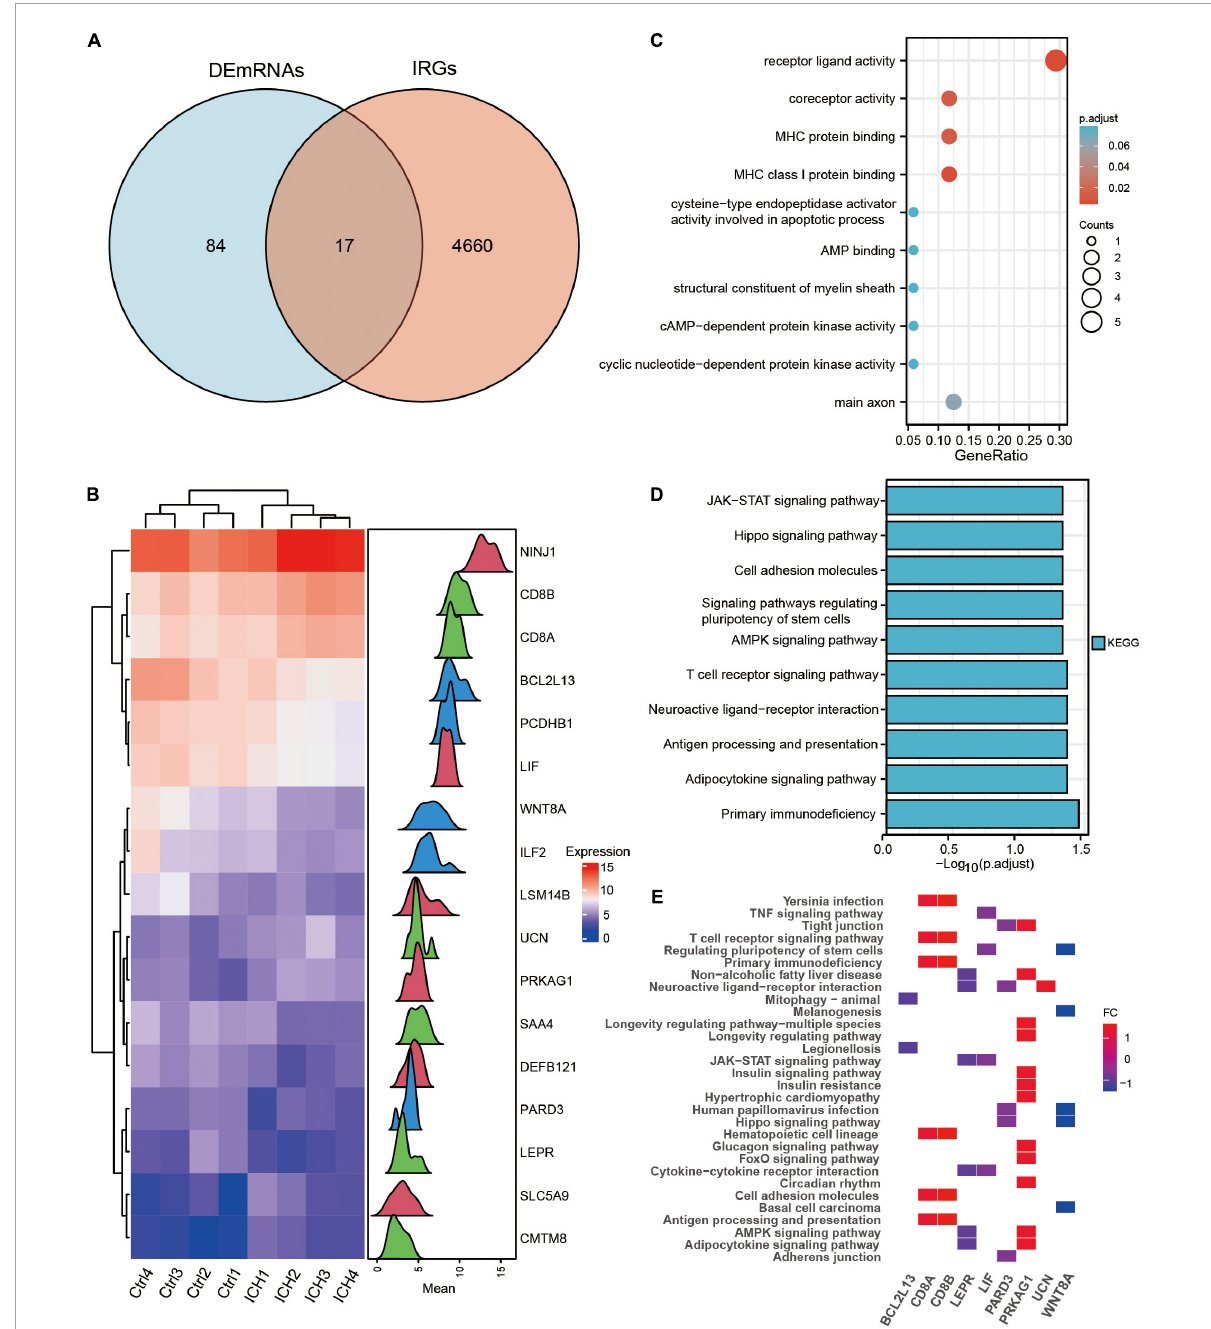
FIGURE5 Identification and functional enrichment analysis of the immune-related DEmRNAs in ICH. (A) The venn diagram showed the intersection genes of DEmRNAs and IRGs in ICH. (B) The heatmap and density plot of the 17 immune-related DEmRNAs in ICH. (C) The top 10 Gene Ontology biological processes of immune-related DEmRNAs in ICH. (D) The top 10 KEGG enrichment analysis of immune-related DEmRNAs in ICH. (E) The heatmap of KEGG pathways of immune-related DEmRNAs in ICH.